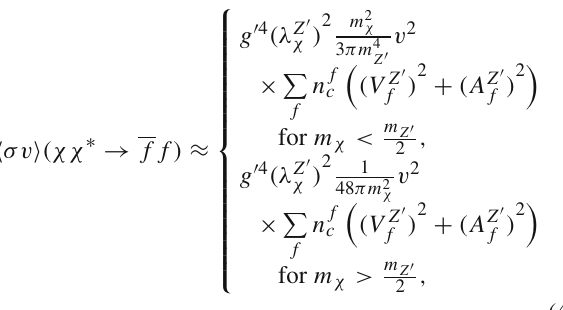
Fig. 12 Summary of constraints for Z (cid:15) portal in the context of a scalar DMforthethreedifferentrealizations(seeTable1),i.e.,SSM(left), E 6 χ (middle) and E 6 ψ (right) in the relevant bi-dimensional plane m Z (cid:15) , m χ for the choice of λ Z (cid:15) χ = 1. In these plots the red contours represent the correct DM relic density. The blue region is already excluded by